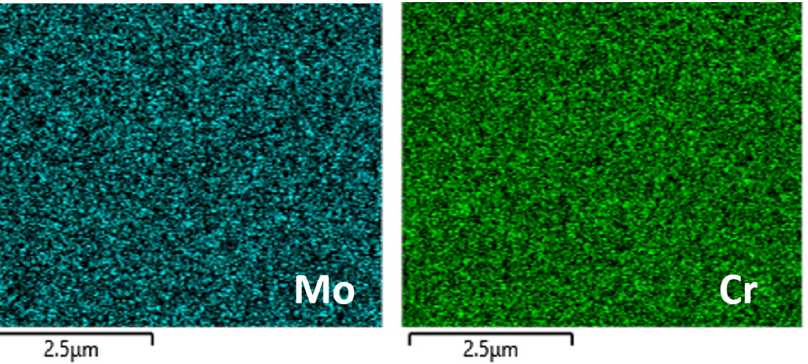
Figure 6. The modified 1.2343 as-built EDS map showing no protruding Mo and Cr on the cell boundaries compared to the standard 1.2343.